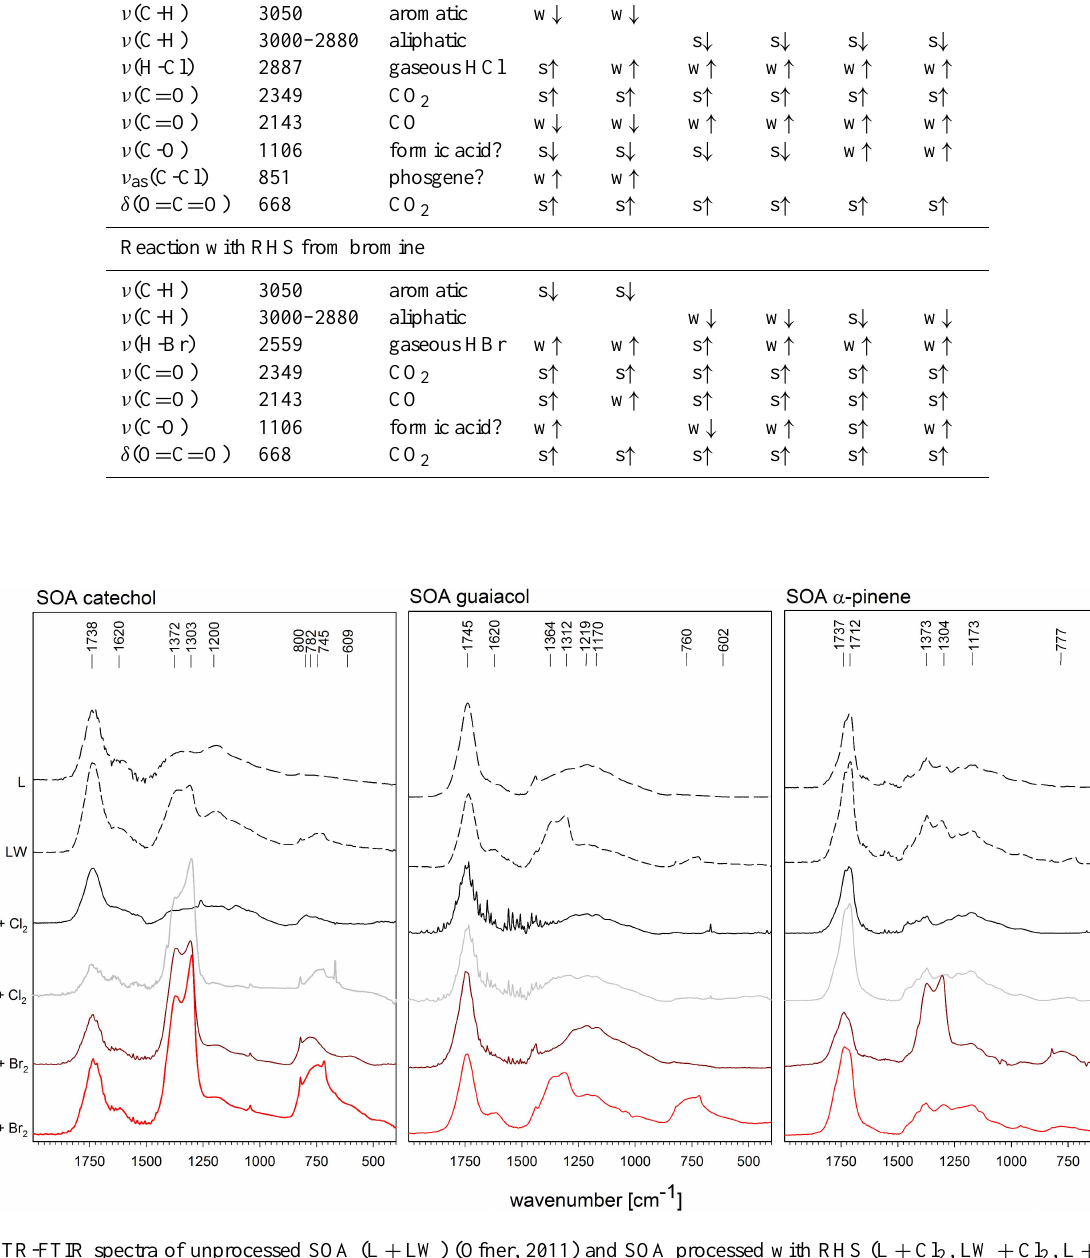
Fig. 5. ATR-FTIR spectra of unprocessed SOA (L + LW) (Ofner, 2011) and SOA processed with RHS (L + Cl 2 , LW + Cl 2 , L + Br 2 and LW + Br 2 ) ; L: SOA formed with simulated sunlight at 0% relative humidity; LW: SOA formed with simulated sunlight at 25% relative humidity; L(W) + halogen: preformed SOA at L(W) condition, processed with RHS formed from the photolyzed molecular halogen